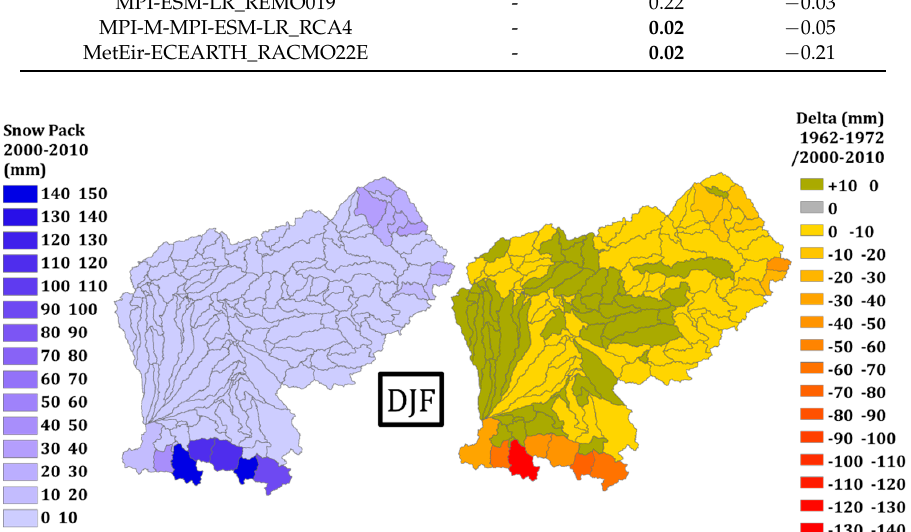
Figure 7. Snowpack during the 2000–2010 decade and variations with the 1962–1972 Figure 7 . Snowpack during the 2000–2010 decade and variations with the 1962–1972 decade.